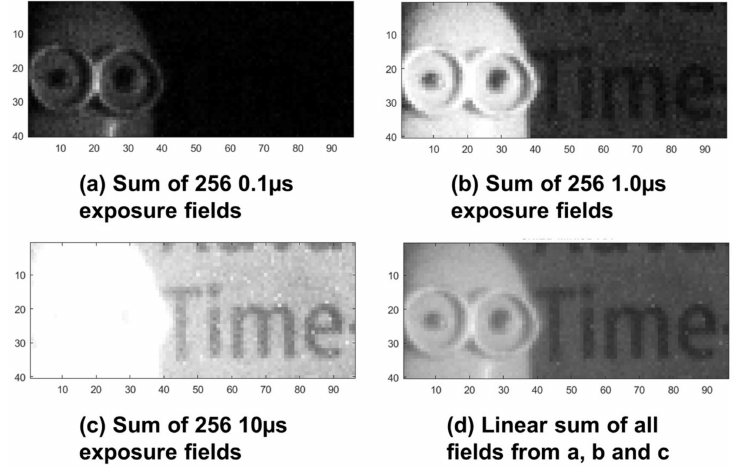
Figure 14. Images captured by 96 × 40 FSI sensor [2]. ( a ) Sum of 256 fields at 0.1 µ s exposure, a Minion figure is visible; ( b ) Sum of 256 fields at 1.0 µ s exposure, the Minion is visible but slightly overexposed while faint letters appear in the background; ( c ) Sum of 256 fields at 10 µ s exposure, the Minion is totally overexposed but the letters appear clearer; ( d ) Linear sum of all the 768 fields from a, b and c to form an HDR image preserving all details.